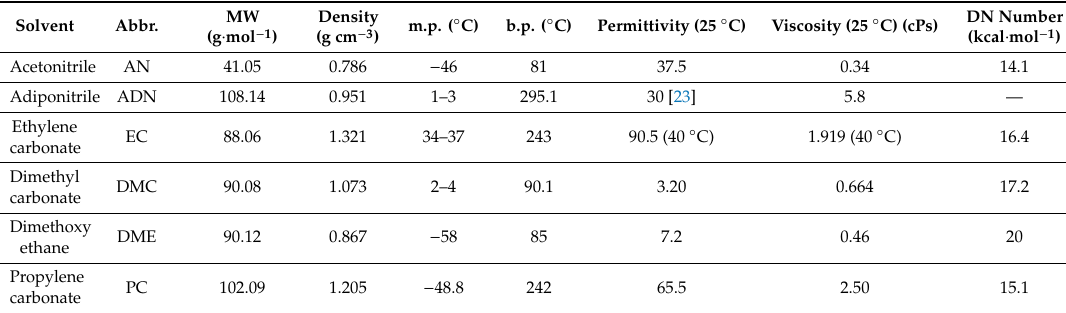
Table 1. Physical properties of commonly used organic solvents for electrical double-layer capacitor (EDLC)